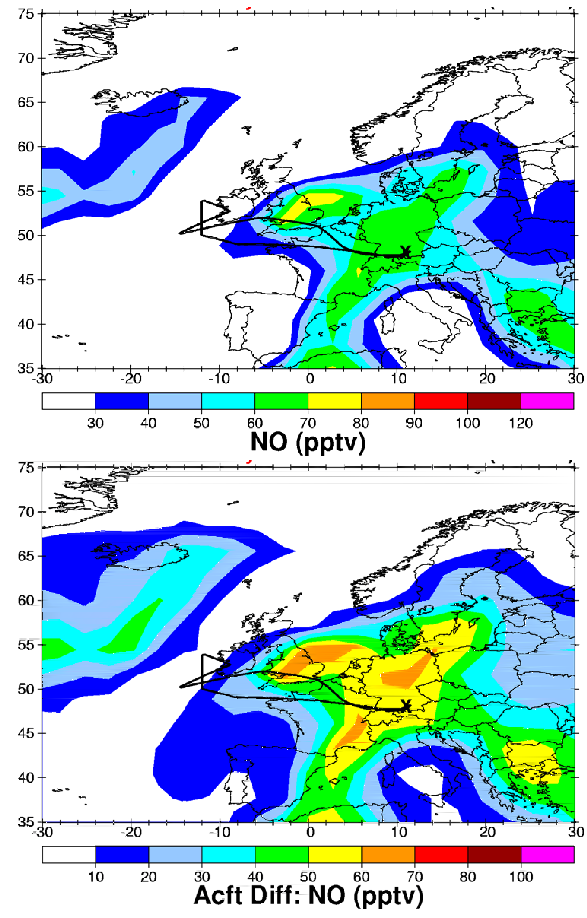
Fig. 11. Simulations with the MATCH-MPIC model of background NO (upper panel) and aircraft NO emissions (lower panel) on 31 October 2008, 12 UT, at 250 hPa above Europe. Also shown is the flight trajectory of the Falcon (a return flight from Oberpfaffenhofen to Shannon, black line).